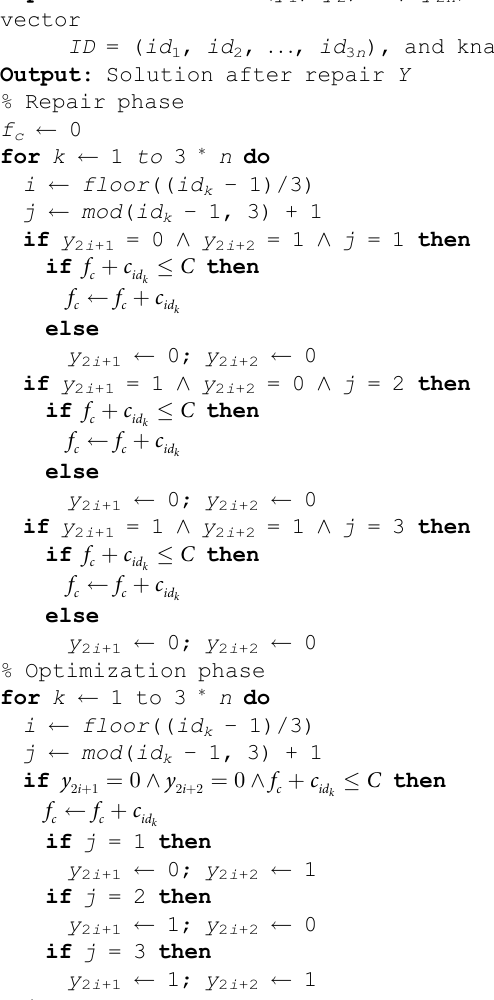
Algorithm 2 : Repair operator